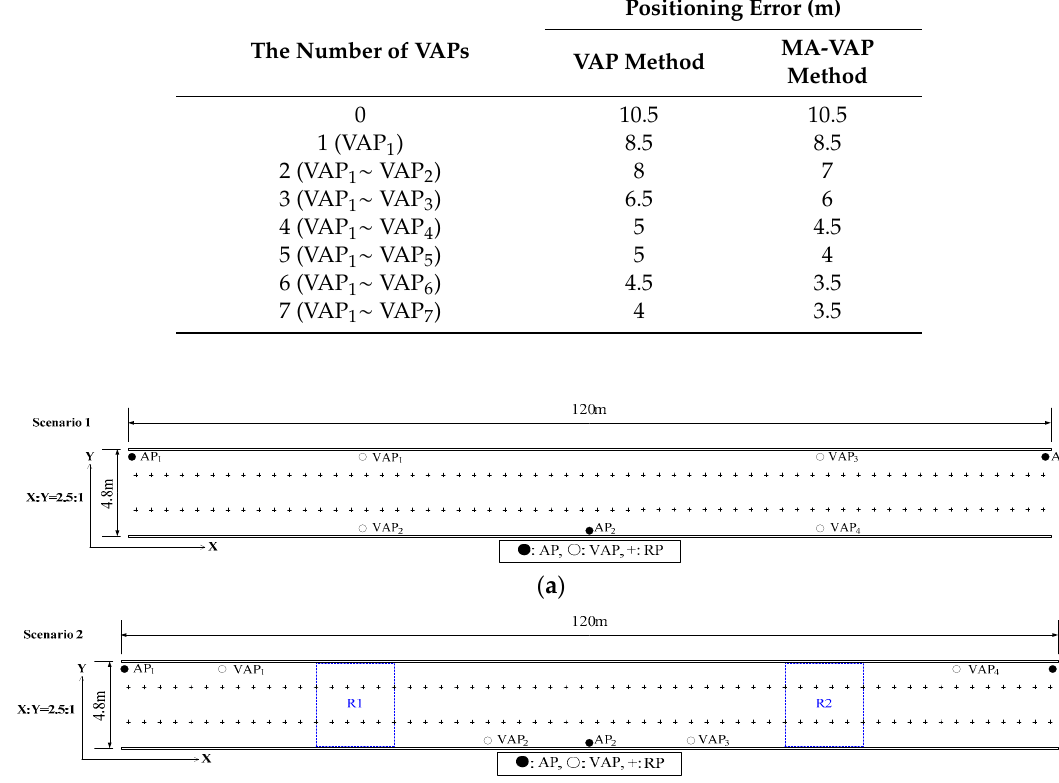
di ff erent numbers of VAPs.